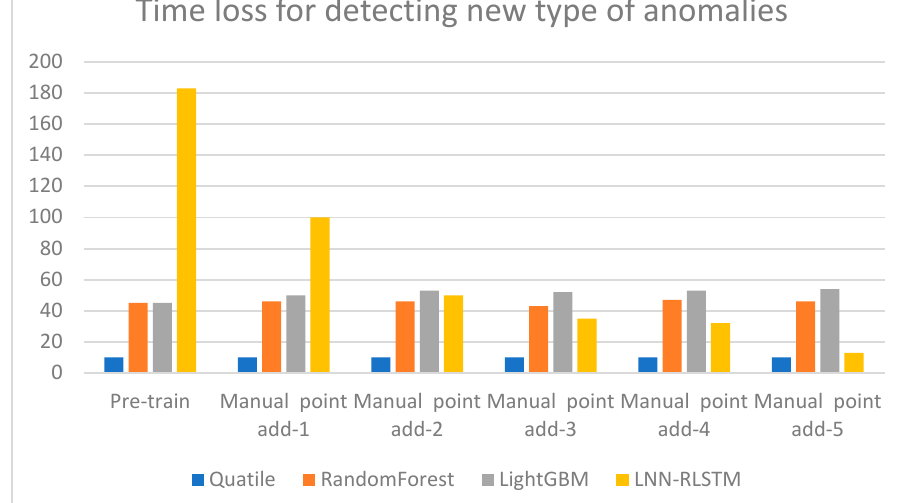
Figure 14. Time loss for training new type of anomalies added manually.